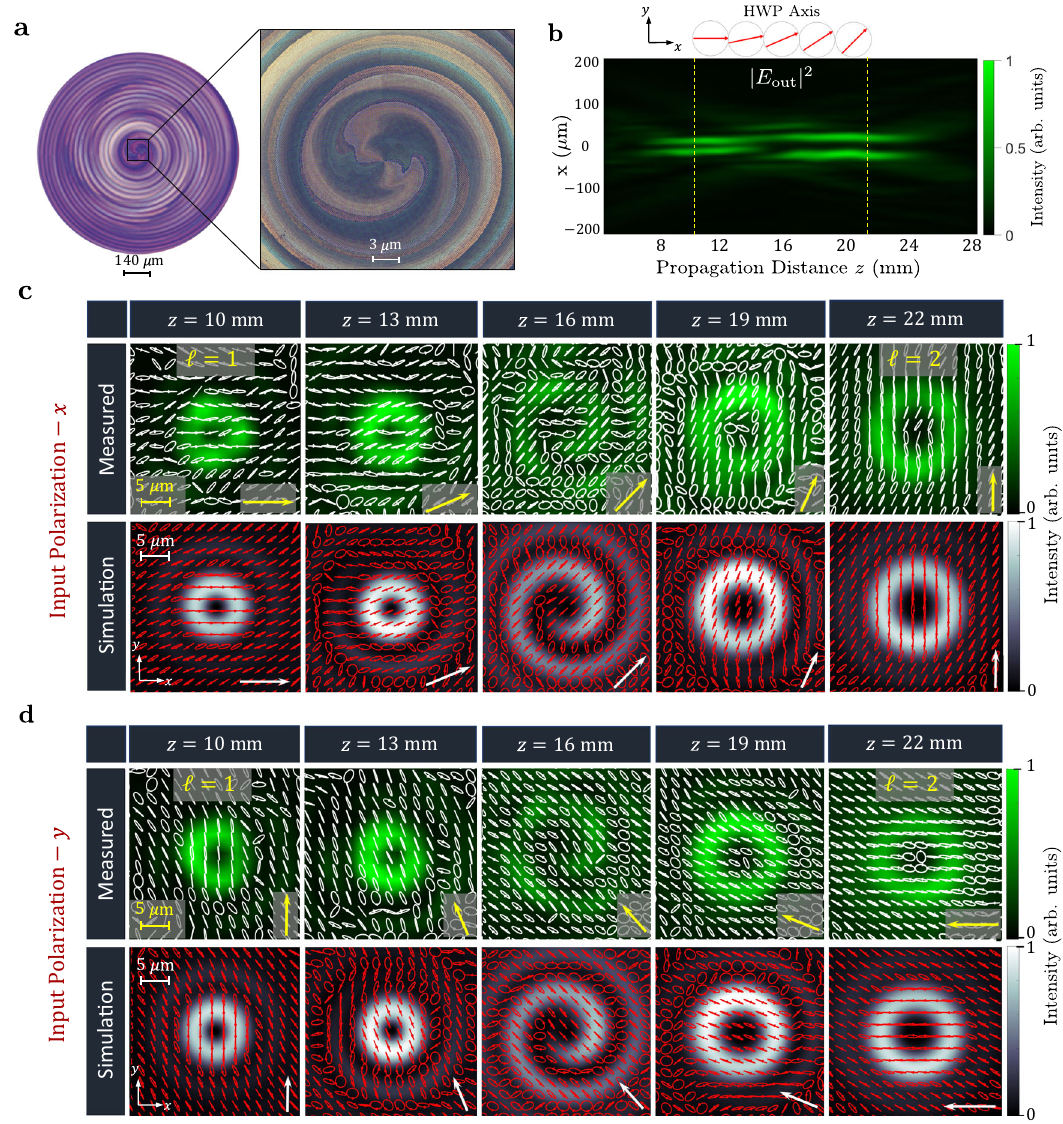
Fig. 5 Versatile TAM plate for independent polarization and OAM control along the direction of propagation. a Optical microscope images of the device. b Measured longitudinal intensity pro fi le at the output in response to incident x -polarization. The polarization response here is chosen to mimic a half-waveplate (HWP) with rotating fast axis, as shown by the red arrows. c Measured and simulated transverse intensity pro fi les of the generated vortex Ψ 1 → 2 in response to x -polarization, exhibiting a transition in the topological charge from ℓ = 1 to ℓ = 2. The state of polarization, obtained from Stokes polarimetry, is shown across the spatial extent of the beam, exhibiting a rotation in the plane of linear polarization at different propagation distances. d Output response of the same device under y -polarization, depicting the evolution of the linear polarization from ^ y to ^ x along the direction of propagation and verifying that the TAM plates can impart its intended response on any incident polarization. The Stokes polarimetry and the evolution of the polarization state on the Poincaré sphere are depicted in Supplementary Fig.